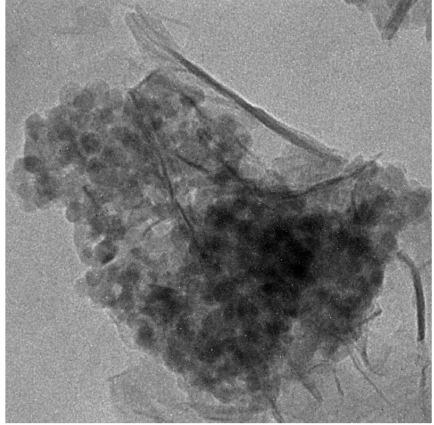
Figure 5. TEM image of reaction product of Sample 2 and Ca(OH) 2 .